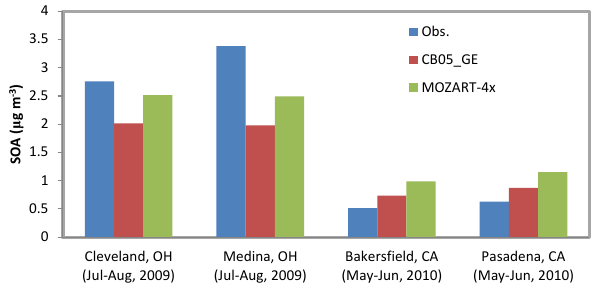
Figure 2. Comparisons of simulated and observed SOA concentra- tions at the four field study sites during 2009–2010. The observa- tions are based on Lewandowski et al.